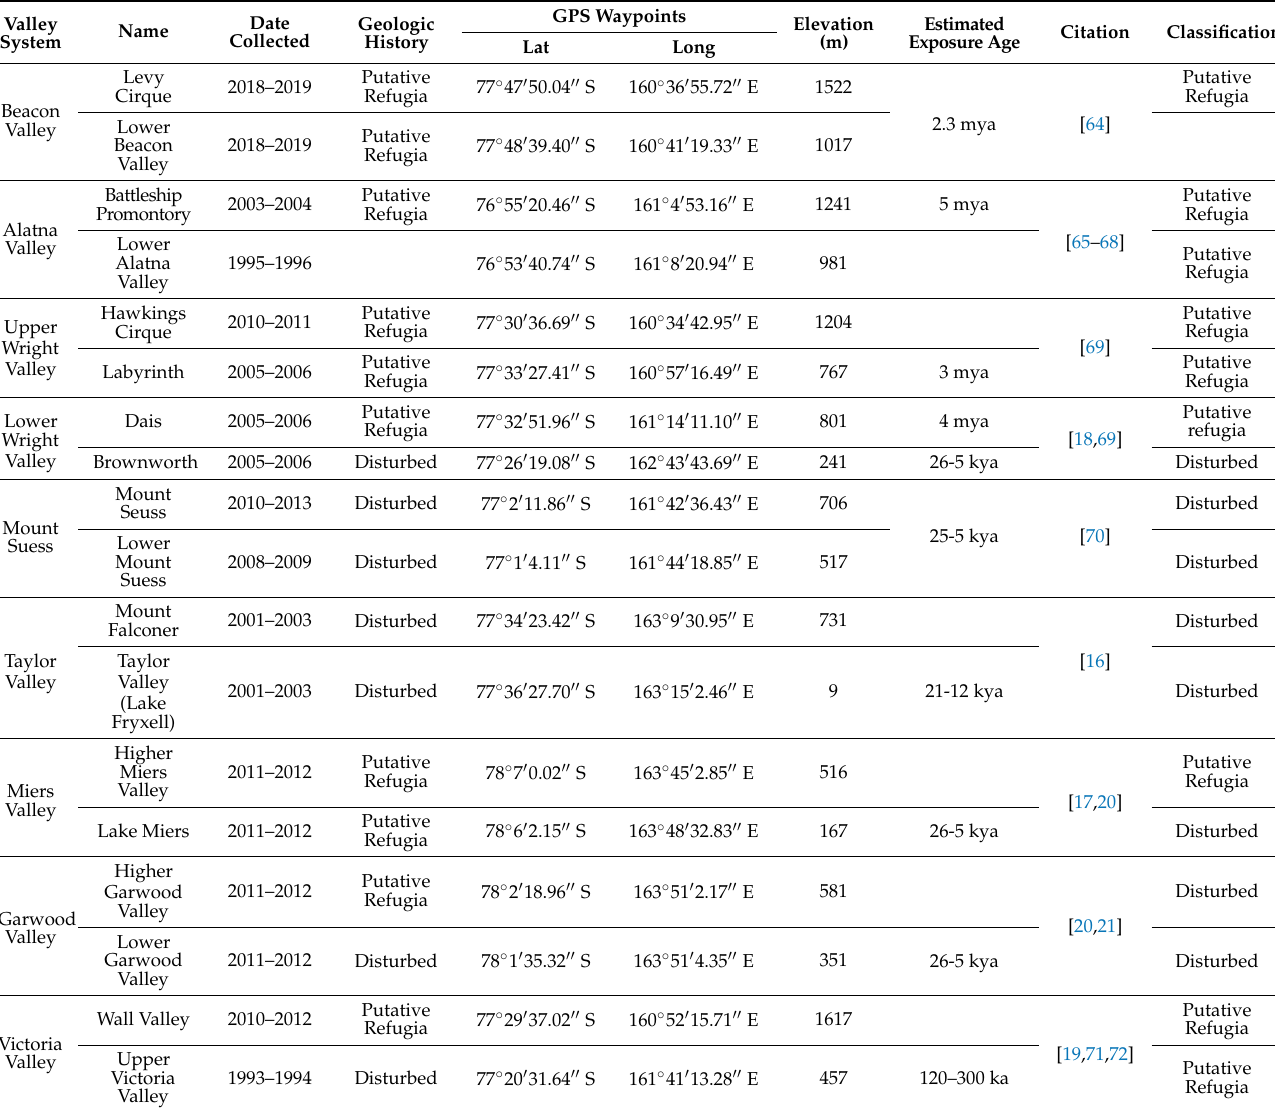
Table 1. Site locations and classification. Location and classification for each site sampled for this study. Note that DNA yields from Lower Beacon Valley were too low to be included in the study. Geological history is based primarily on exposure age estimates from the literature. Citations refer to the primary sources with referenced exposure age estimates for that